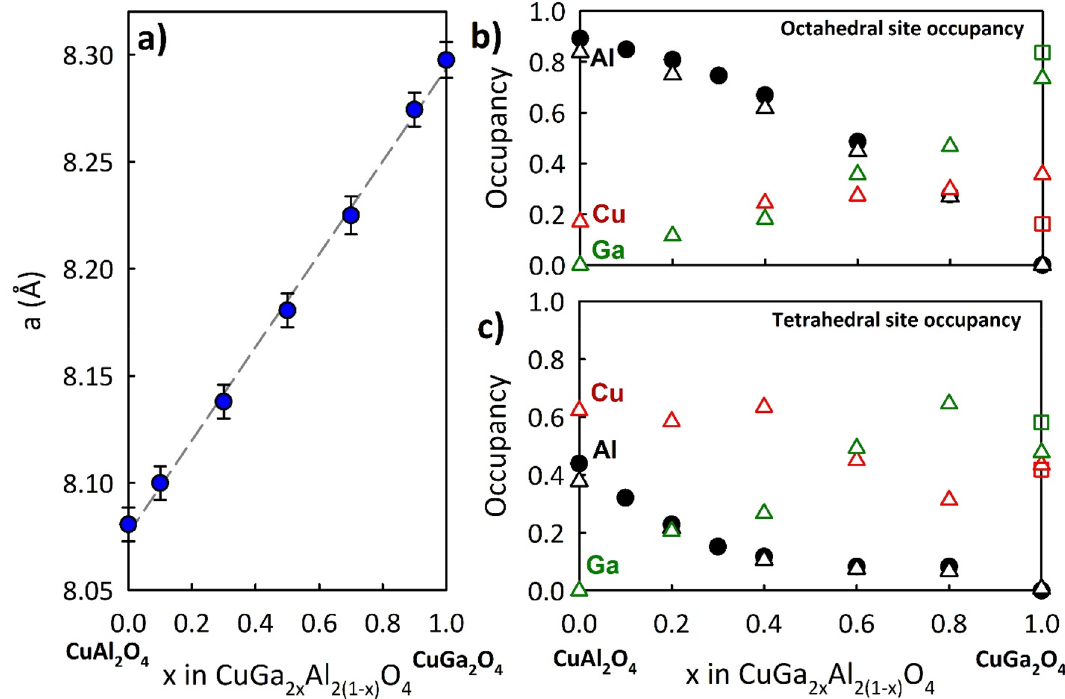
Figure 2. (a) Lattice parameter versus Ga fraction x. Results show linear behavior following Vegard’s law. Occupancy for the octahedral (b) and (c) tetrahedral sites. Circles indicate data derived from the synchrotron diffraction measurements; triangles indicate neutron diffraction derived data. Uncertainty for the results in (b,c) 5% . is ∼